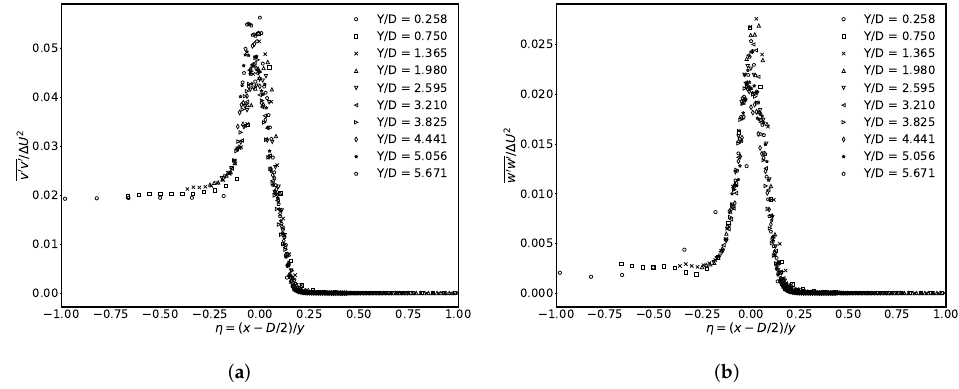
Figure 10. Self-similarity plots of the mixing layer’s Reynolds stress profiles, v (cid:48) v (cid:48) and w (cid:48) w (cid:48) confirm the presence of relatively high turbulent intensity values on the high velocity potential core side of the profiles. ( a ) Streamwise Reynolds stress, v (cid:48) v (cid:48) . ( b ) Cross-stream Reynolds stress, w (cid:48) w (cid:48)